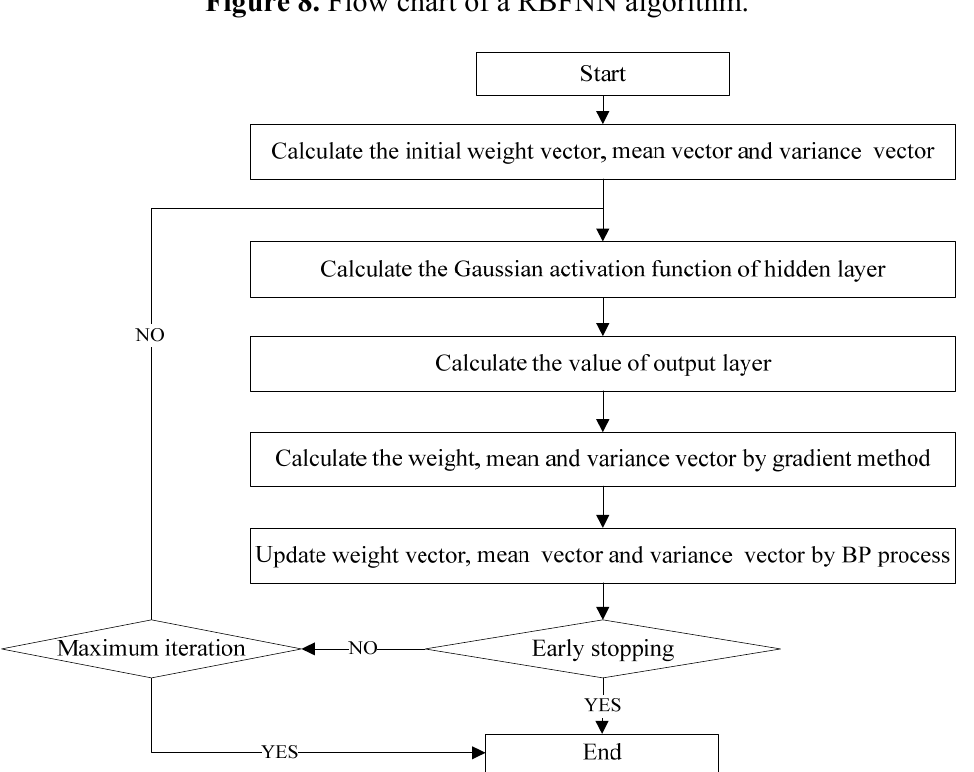
Figure 8. Flow chart of a RBFNN